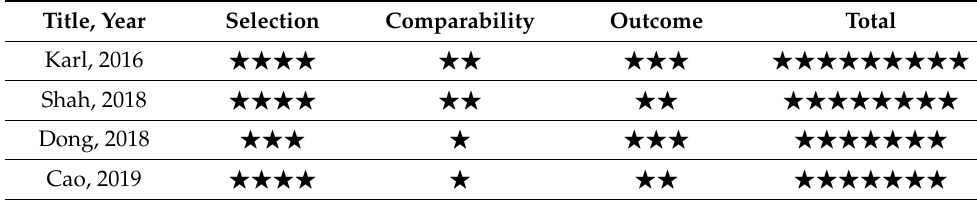
Table 2. Newcastle Ottawa scale. Quality assessment of cohort studies using the Newcastle Ot- tawa